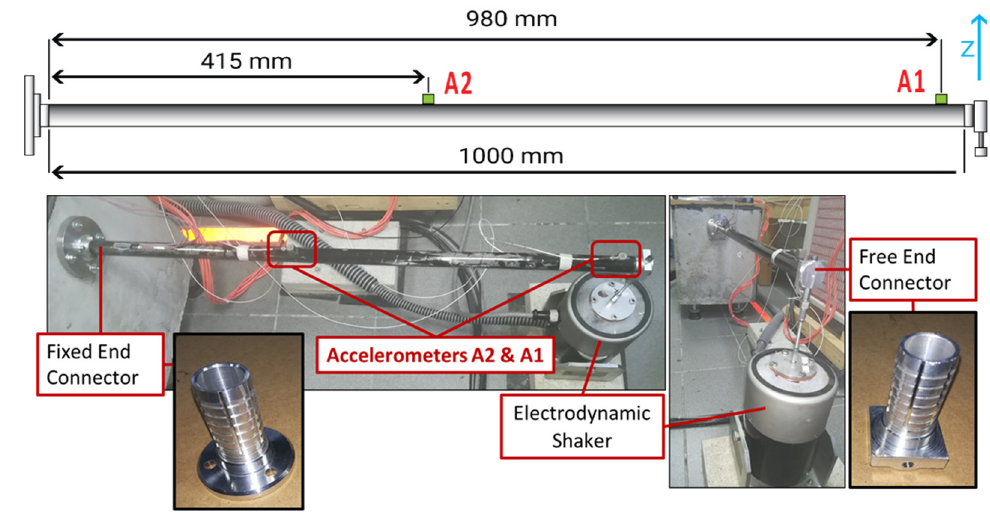
Figure 16. Complete experimental set-up of the CFRP composite beam.